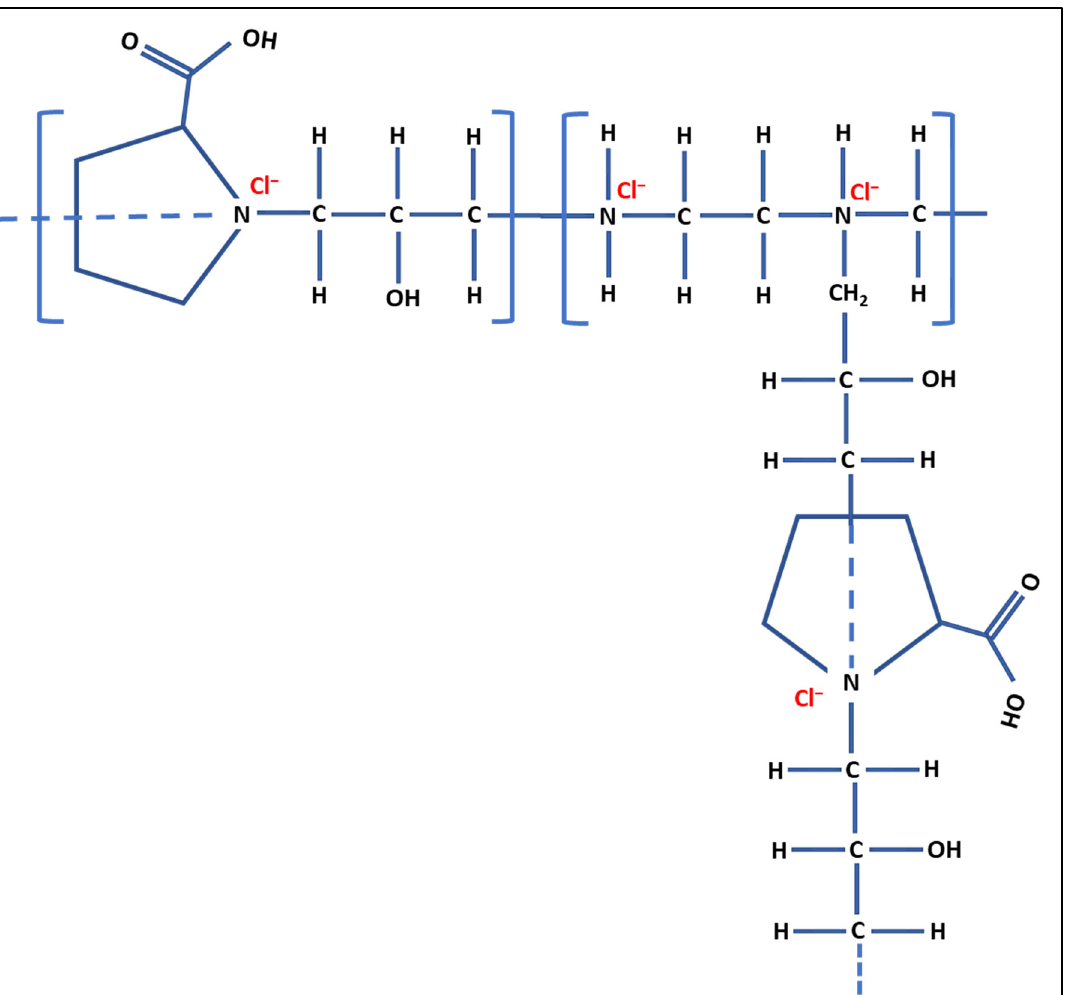
Figure 1. Schematic for formation of